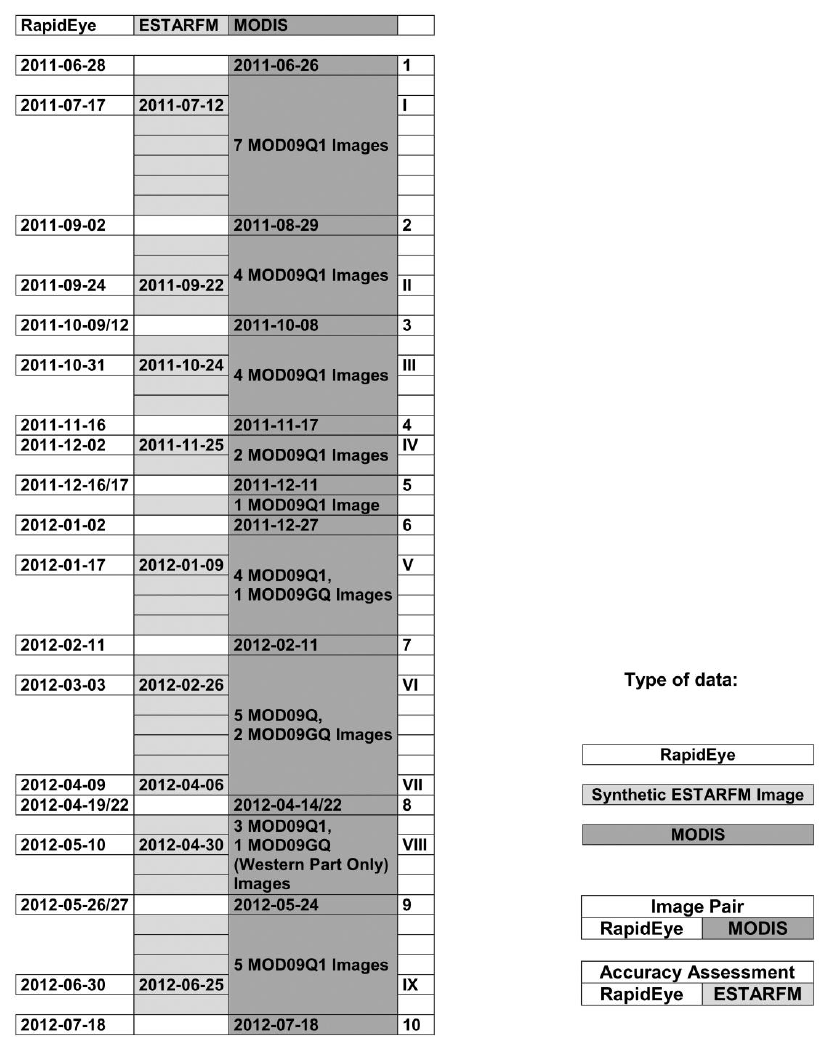
Figure 2. Timeline of acquisition dates of RapidEye and MODIS scenes used for this